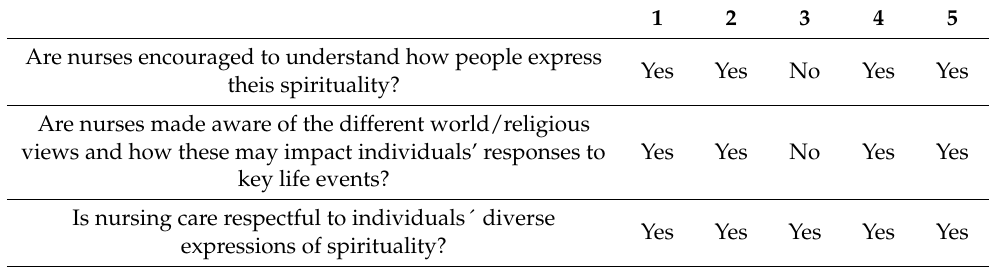
Table 1. Summary of results about nurses’ approach and awareness to patients’ spirituality.